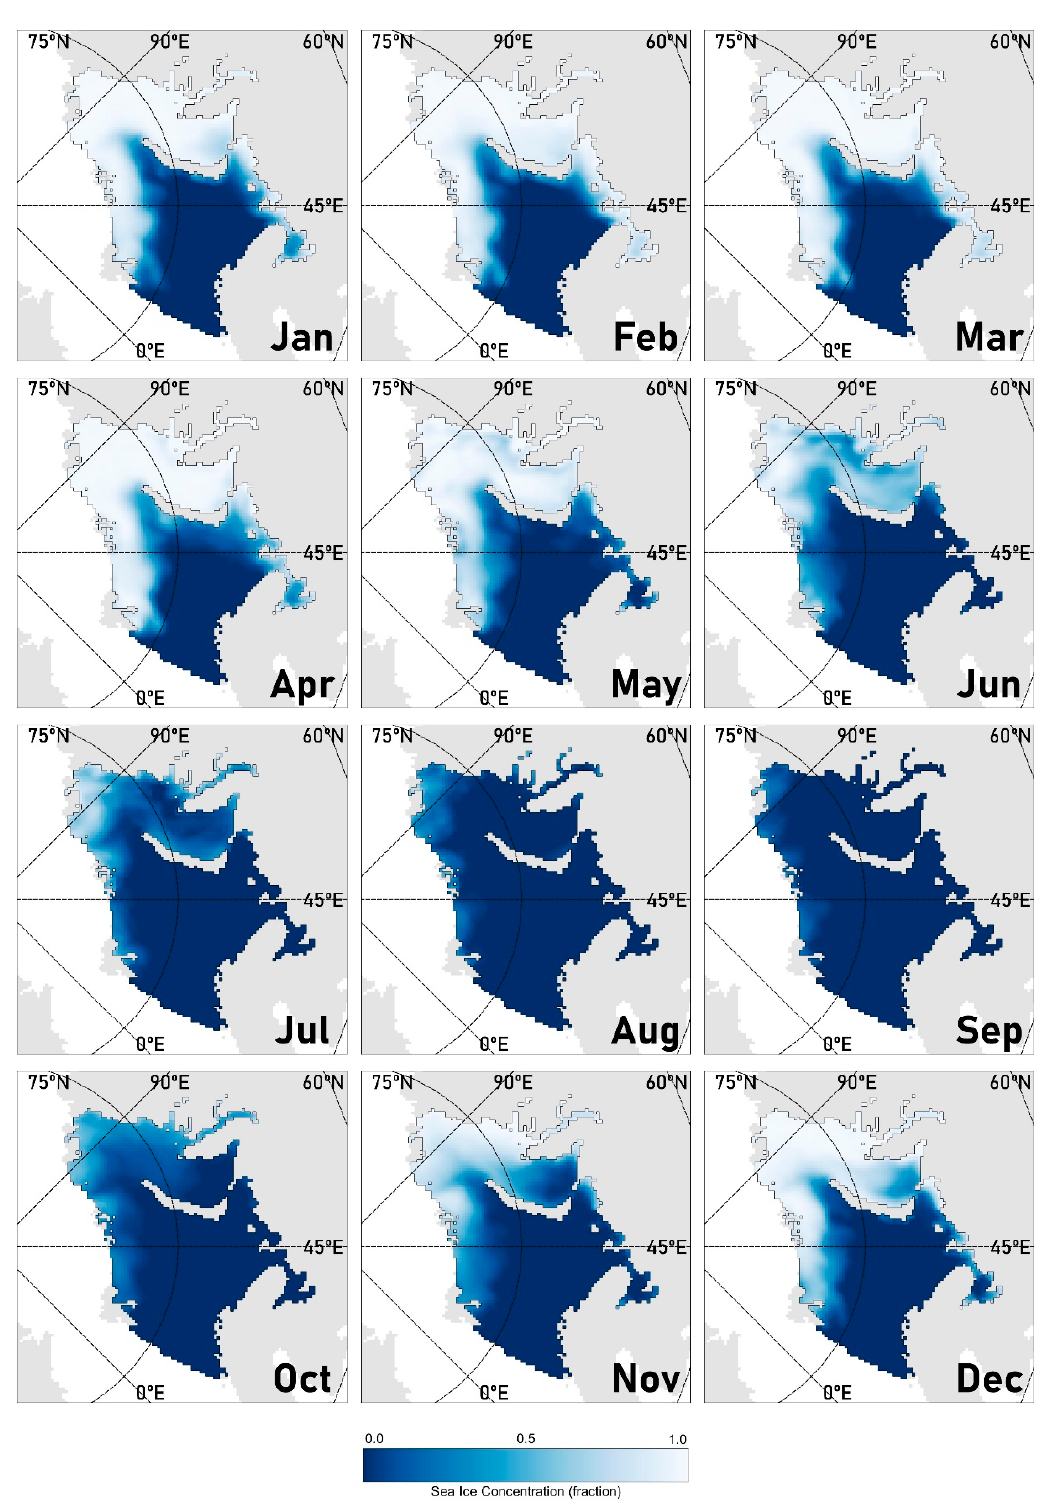
Figure 7. Monthly averages of sea ice concentration from satellite observations of the Kara and Barents Seas during 2006–2016.